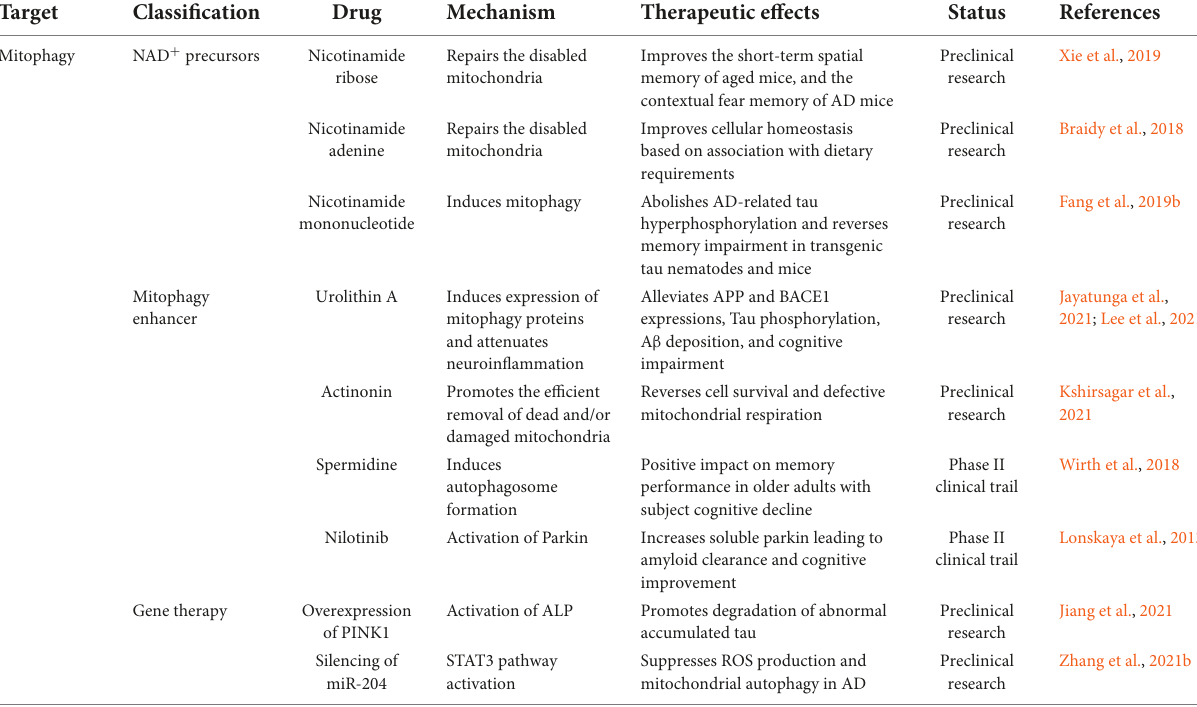
TABLE 2 Alzheimer’s disease (AD) therapeutic strategies targeting